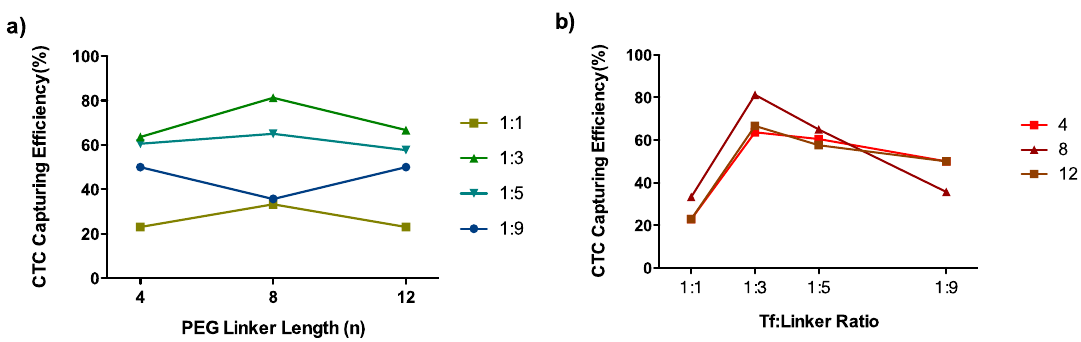
Figure 4. CTC (HCT 116) capturing efficiency represented against ( a ) the linker length and ( b ) the Tf to PEG linker ratio.